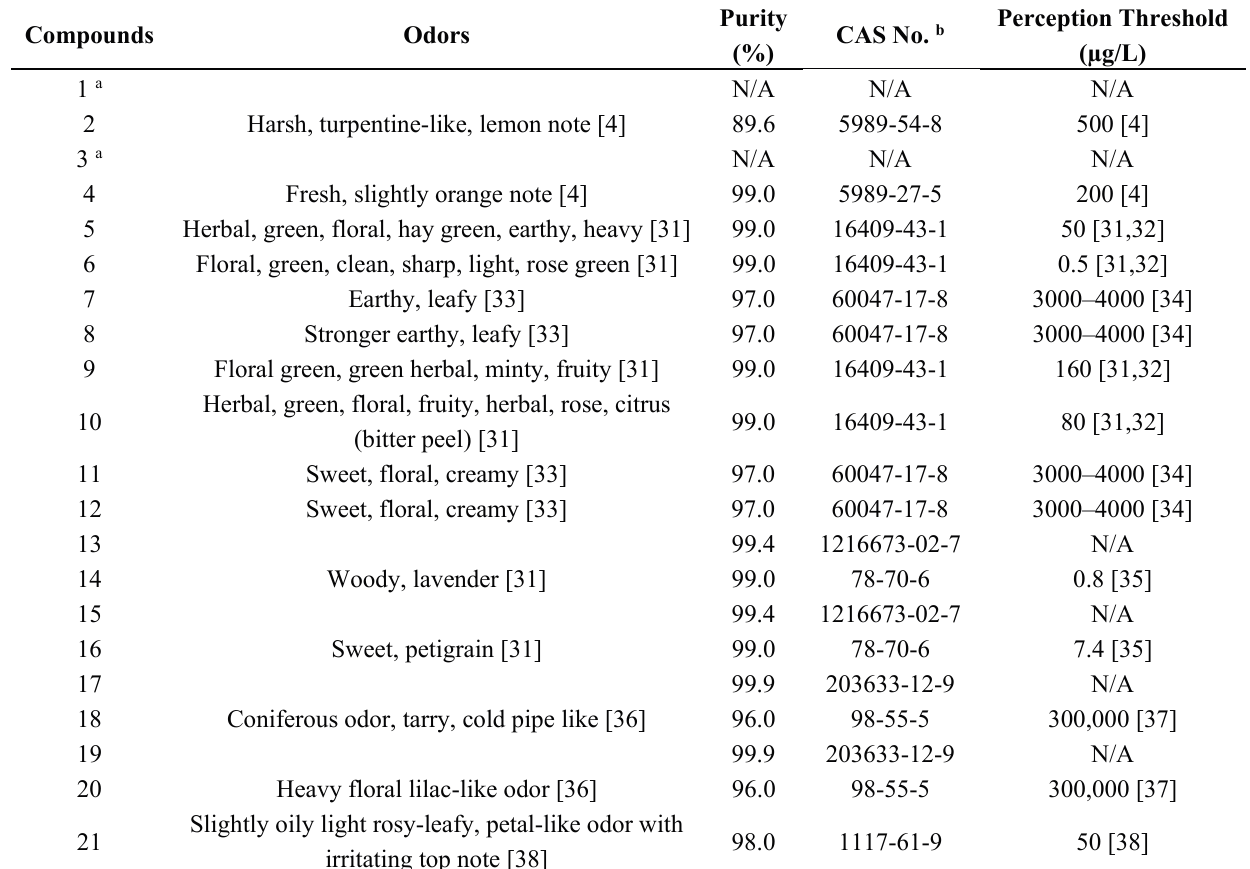
Table 5. Odor descriptors, purity, CAS# and perception threshold (µg/L) for chemical standards.